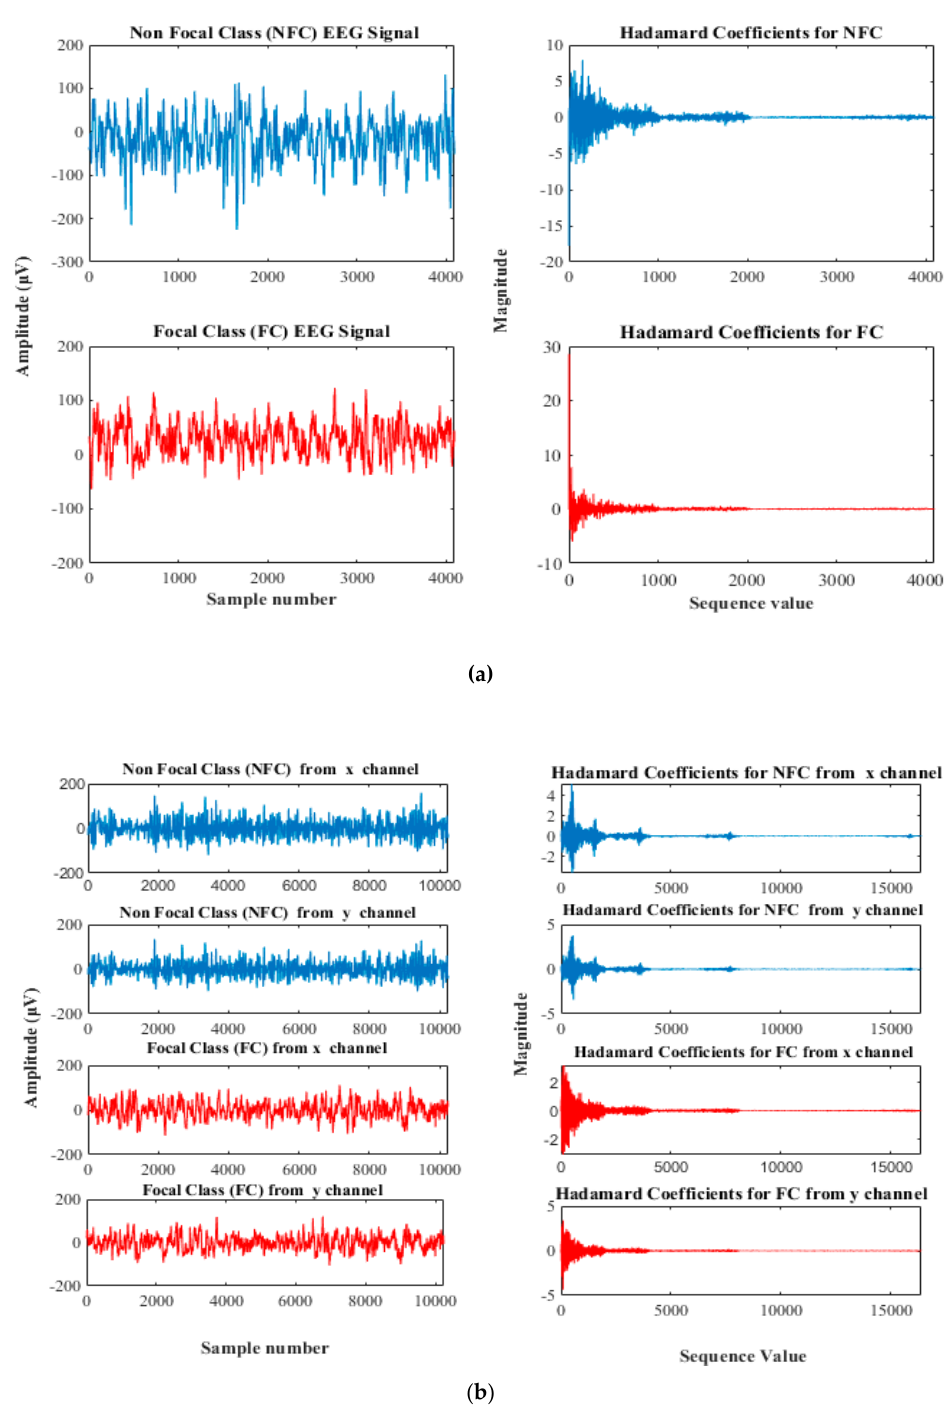
Figure 5. The plot of EEG signal and its Hadamard coefficient for ( a ) University of Bonn and ( b ) Bern-Barcelona Dataset.